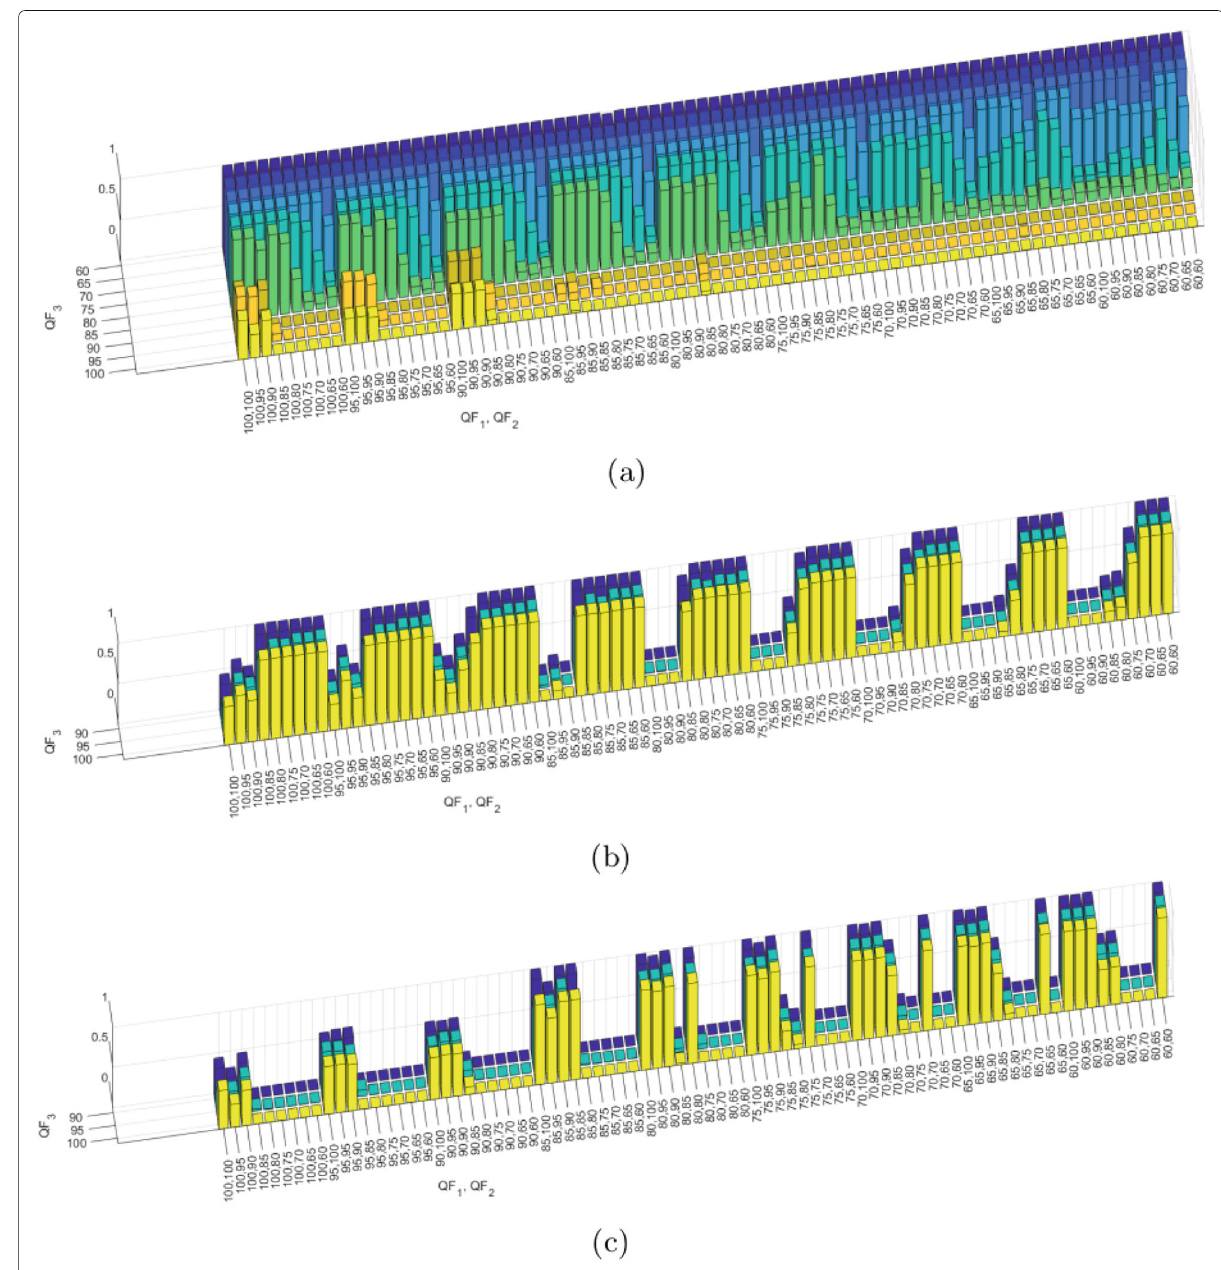
Fig. 9 Accuracy of the proposed method on JPEG 4-compressed images employing all the combinations QF 1 , QF 2 , QF 3 ∈ { 60,65,70,75,80,85,90,95,100 } and QF 4 = 90 considering QF 3 as ground truth (a). Further analysis have been conducted with QF 3 ∈ { 90,95,100 } (low accuracy regions): (b) and (c) show the results employing QF 2 and QF 1 as ground truth respectively